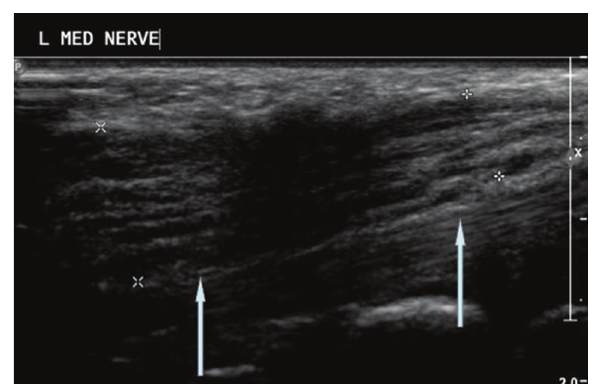
FIGURE 2: Longitudinal ultrasound image demonstrates fusiform enlargement of the median nerve with alternating hypoechoic and hyperechoic linear bands, resulting in a ‘ spaghetti-like’ appearance (white arrows).